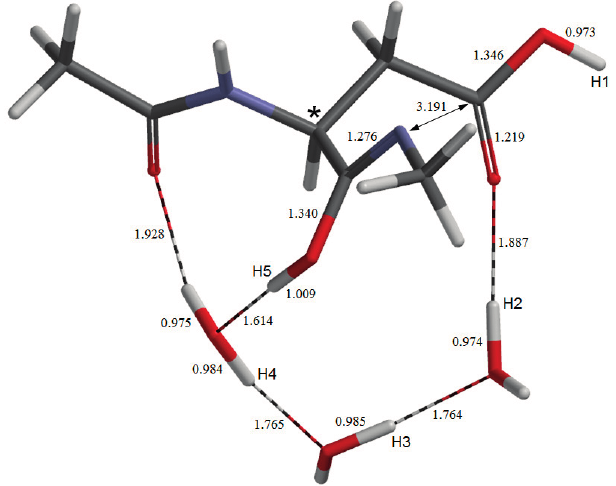
Figure 7. The geometry of the third intermediate IM2 . Selected bond distances are shown in